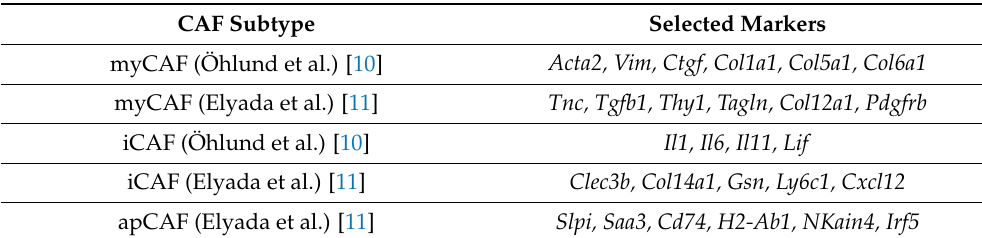
Table 6. Lists of selected markers for myCAF, iCAF, and